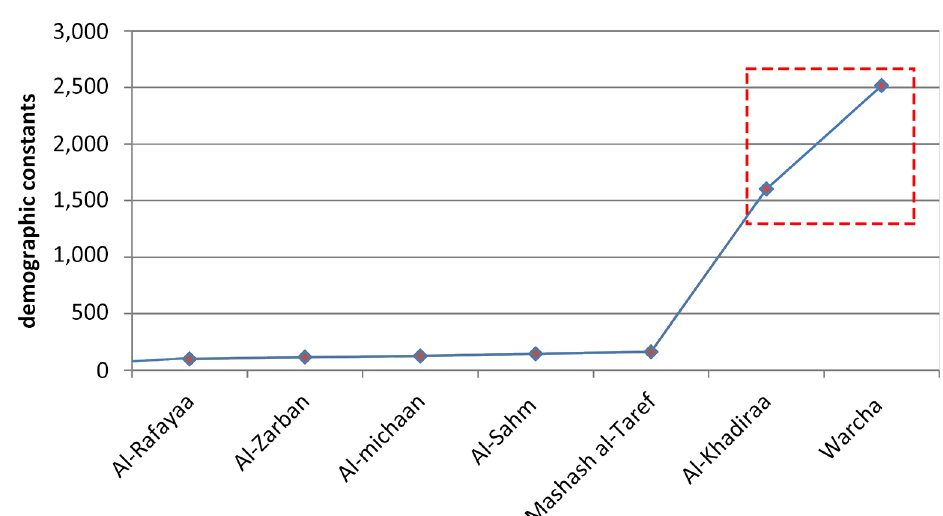
Fig. 9. Zoom shot of level 7 of the curve.